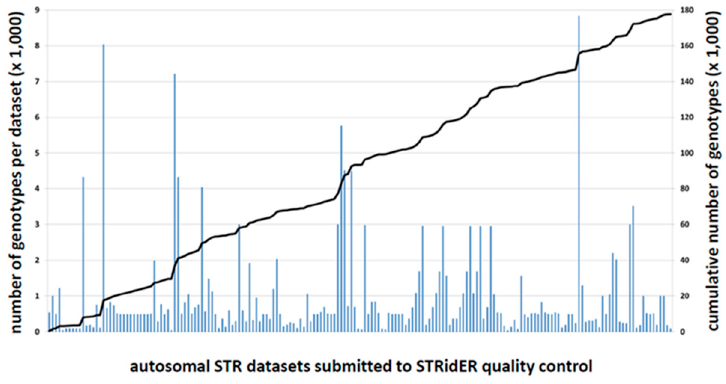
Figure 1. Submissions to STRidER (STRs for Identity ENFSI Reference Database) for quality control in the first two years. Bars indicate the 184 submitted datasets in chronological order of submission between July 2017 and July 2019, dataset size according to the left axis; line indicates the cumulated number of samples over all submitted datasets according to the right axis. Table 1. Statistics of autosomal short tandem repeat (STR) datasets submitted to STRidER in its first two years and quality control outcome.